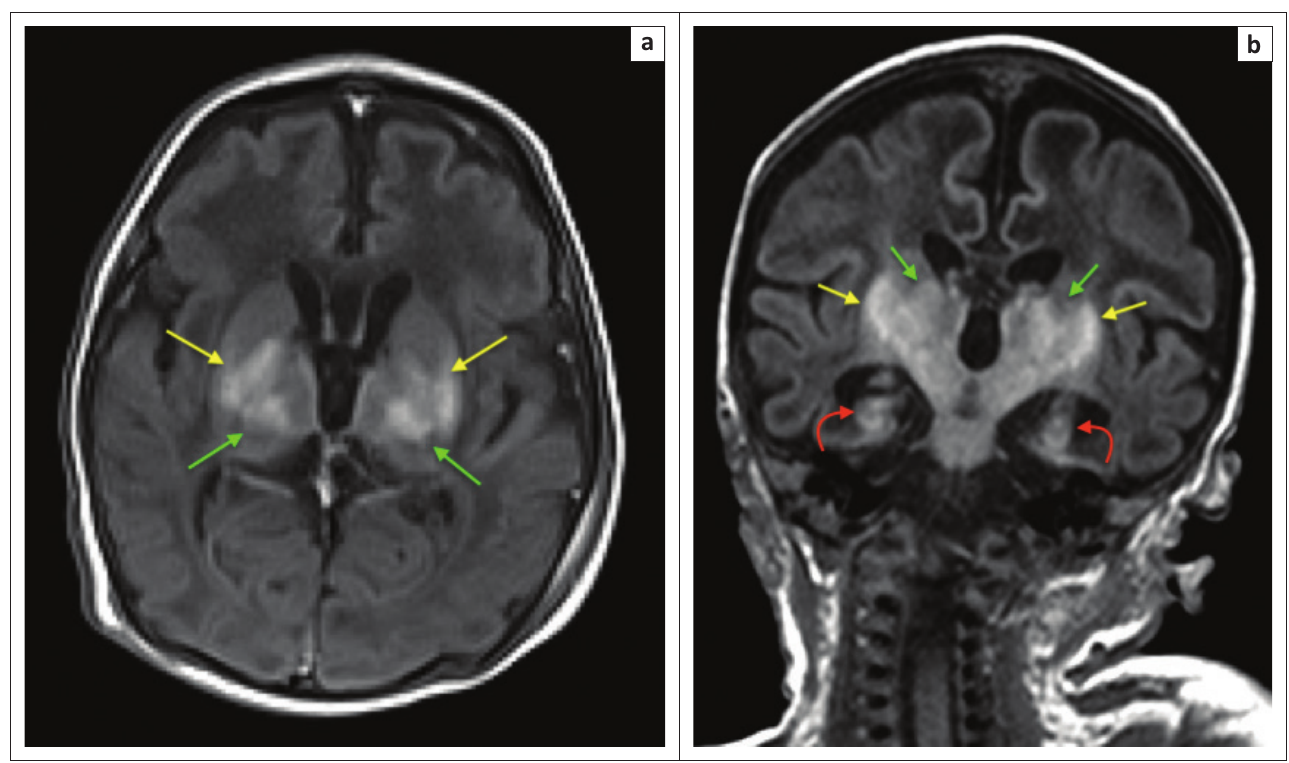
FIGURE 4: Two-week-old neonate born with grade 3 hypoxic ischemic brain injury and neonatal seizures. (a) An axial T1-weighted sequence showing signal shortening at the dorsal putamina (yellow arrows) and ventral thalami (green arrows). (b) Note, in addition to the basal ganglia and thalamic changes, the hyperintense signal and volume loss at both hippocampi (red